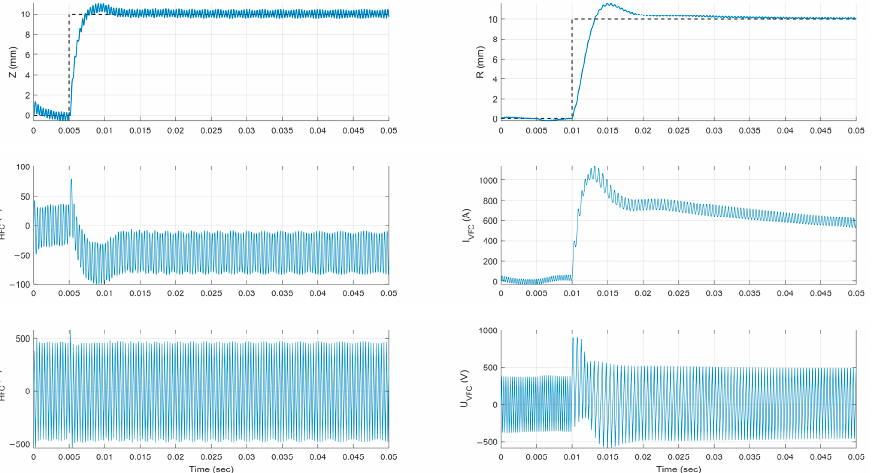
Figure 6. Step responses of closed-loop systems with a plasma model corresponding to 185 ms of shot #37239 with nonlinear current inverter models [15] and PID-controllers (9), tuned with the QFT methodology.